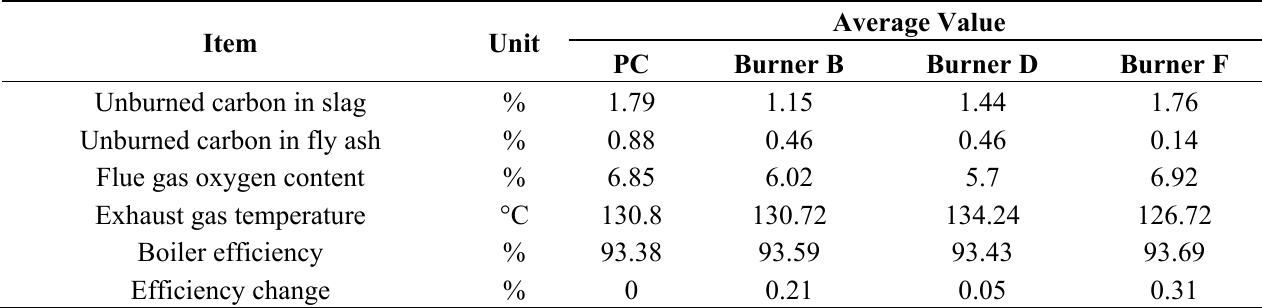
Table 5. Summary of boiler